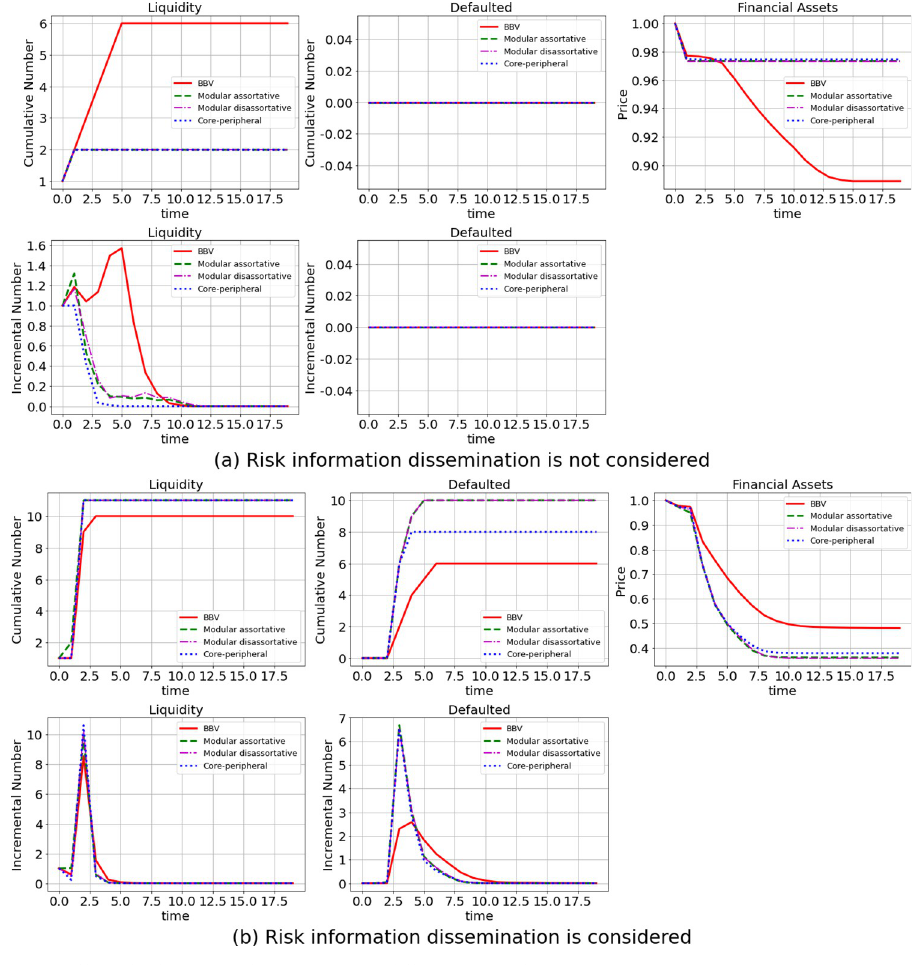
Fig 5. Effect of information dissemination in different